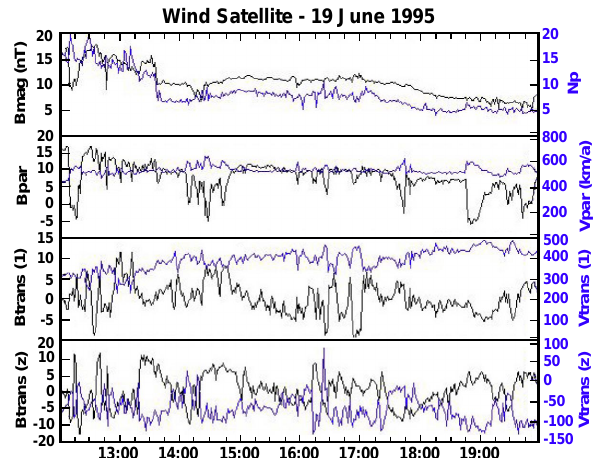
Fig. 6. Geotail data in the solar wind inside the compression region, 7 April 1995. Top panel: magnetic field and density; second panel: b || and v || , bottom two panels: transverse components of b and v .